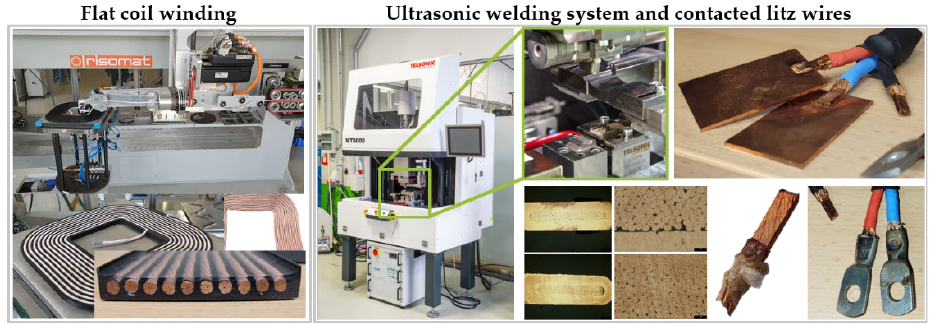
Figure 5. Manufacturing cell for flat coil winding ( left ), ultrasonic welding system and contacted litz wires ( right